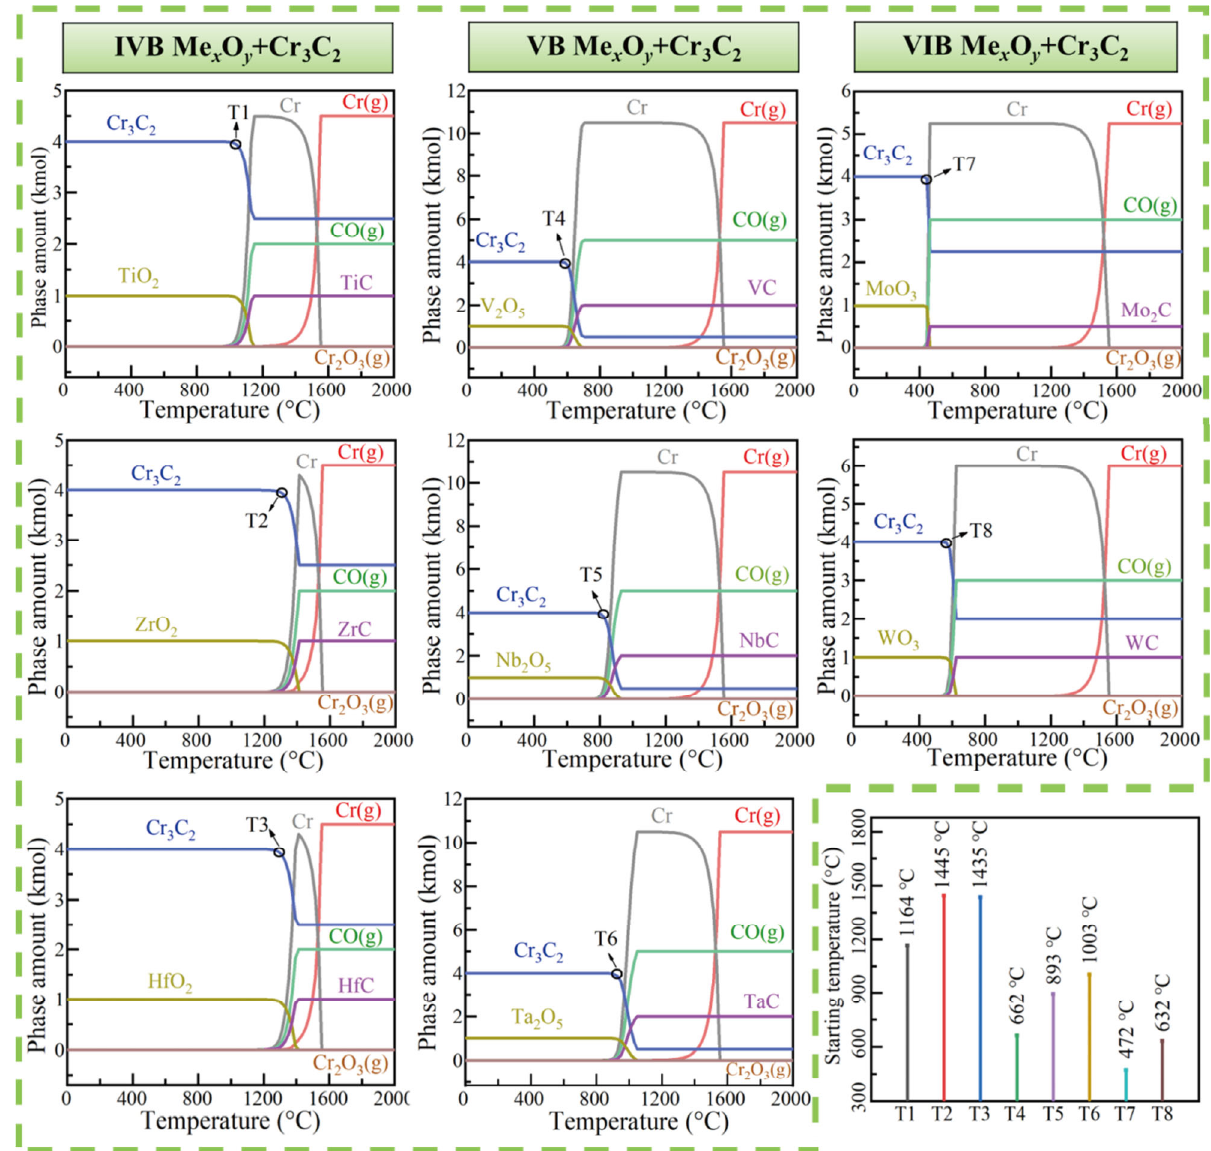
Fig. 5 Calculated phase equilibrium diagrams of Me x O y –Cr 3 C 2 systems under a total gas pressure of 20 Pa and starting temperatures of the oxygen-removing